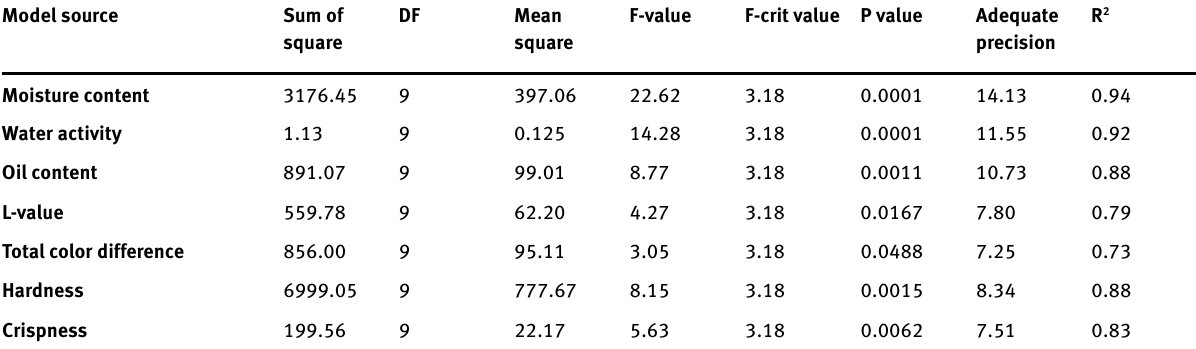
Table 3 : Analysis of variance (ANOVA) for the regression models of moisture content, water activity, oil content, L value, total color difference, hardness and crispiness of sweet potato